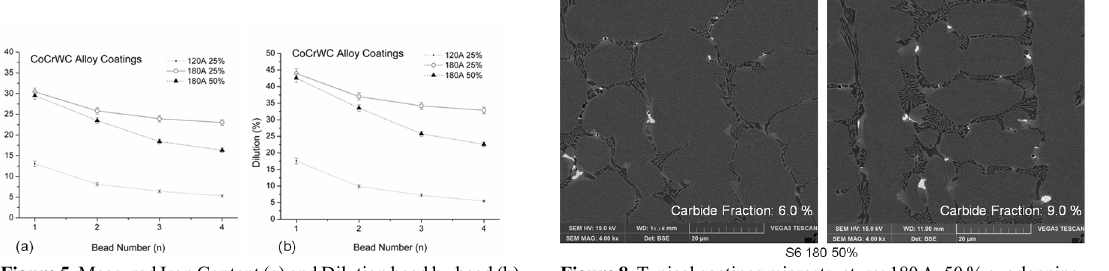
Figure 4. Typical macrography of the coatings.